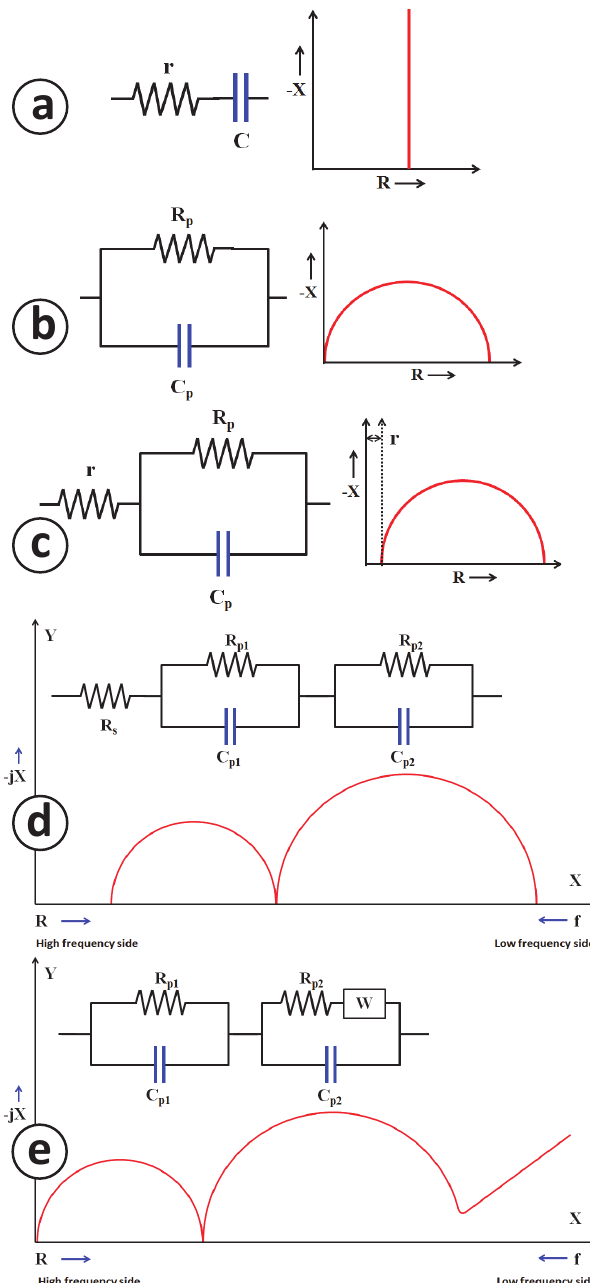
Fig.2: Nyquist plots for different circuit combinations. (a) Nyquist plots for a circuit combination containing a resistor r and a capacitor C in series, (b) Nyquist plots for a circuit combination containing a resistor R p and a capacitor C p in parallel (R p ||C p ), (c) Nyquist plots for a circuit combination containing two sub-circuit blocks with a series resistance of R s and the parallel combination of R p and a capacitor C p (R p ||C p ) (d) Nyquist plots for a circuit combination containing three sub- circuit blocks with a series resistance of R s , (R p1 ||C p1 ) and (R p2 || C p2 ). (e) Nyquist plots for a circuit combination containing two sub-circuit blocks, (R p1 ||C p1 ) and ((R p2 + Warburg impedance (W)) || C p2 ), connected in series.